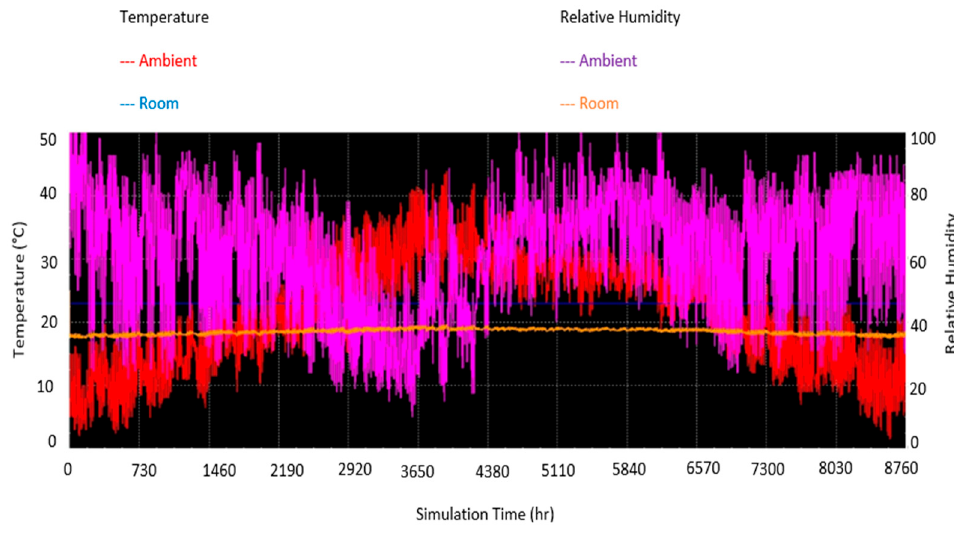
Figure 12. One year simulation run for option A.